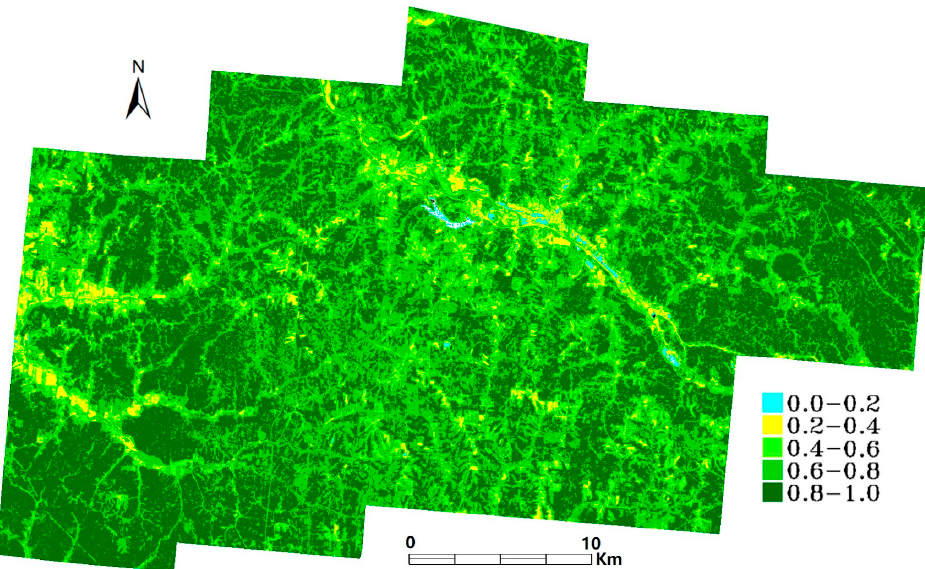
Figure 4. Normalized difference vegetation index (NDVI) values of Landsat image acquired in the peak season (20 June).